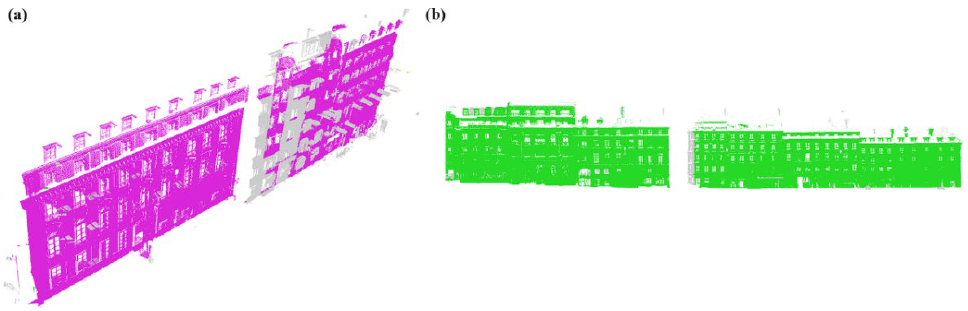
Figure 5. Different facades are identified as one: ( a ) two facades whose spatial locations are adjacent to each other are considered as one facade but are not coplanar; ( b ) similar facades of different buildings are incorrectly considered as one facade.